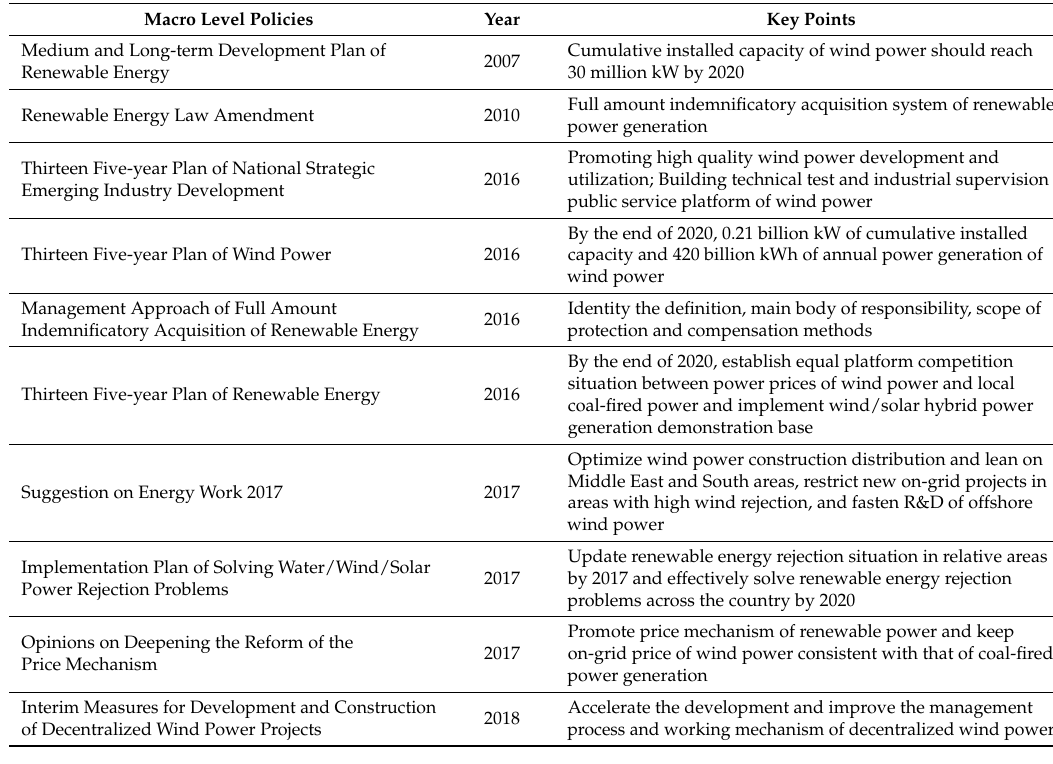
Table 3. Macro level policies of wind power in China.